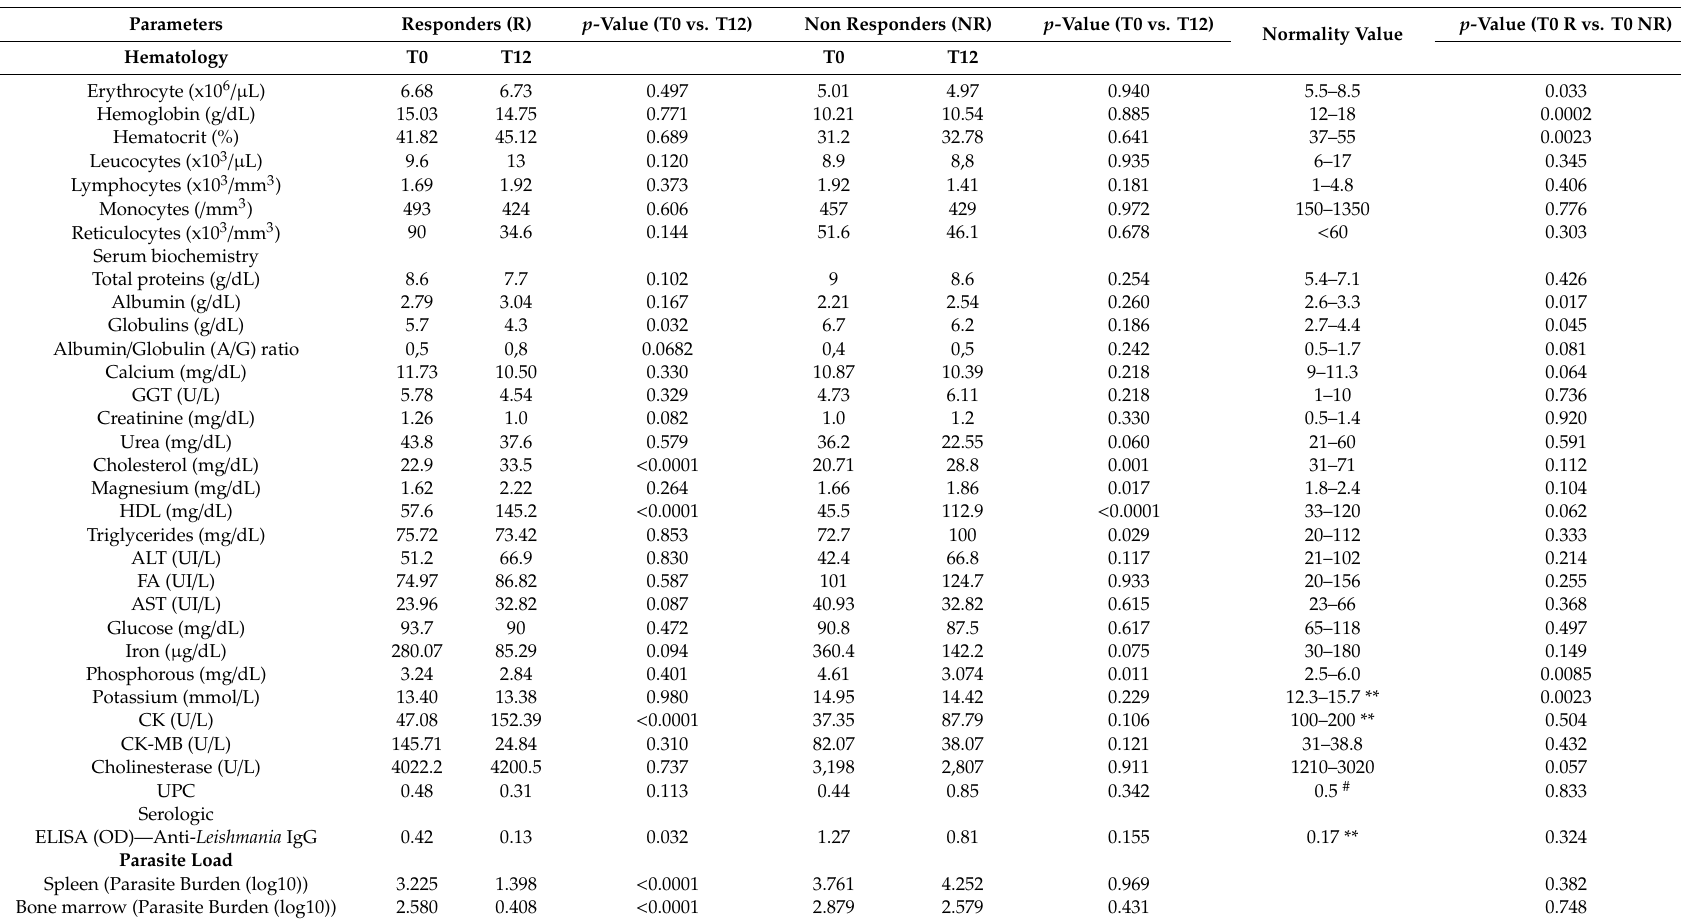
Table 1. Values of hematological, serum biochemistry, oxidative stress parameters and parasitic load of the initial and final times of the responder and non-responder dogs to the